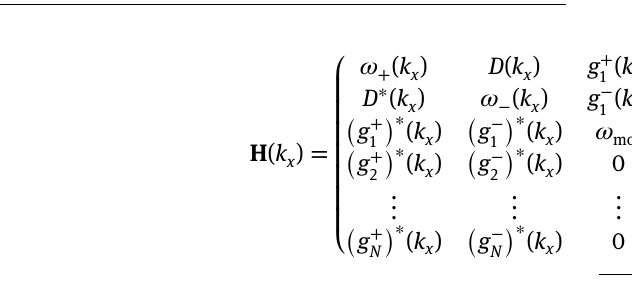
relation become degenerate and we observe only four distinct bands as seen in Figure 4(b) for S = 0. When the spatial distribution of molecules extends through the full grating profile, the breaking of finite translational + Λ results in the onset of a fifth distinct → x invariance x i i band in the dispersion relation as seen in Figure 4(c) for S = Λ . In Figure 4(d), we plot the eigenvalues of the = 0.1 μ m for 0 ≤ S ≤ Λ . We can system Hamiltonian at k x see that as S → 0, the N − 4 dark resonances and